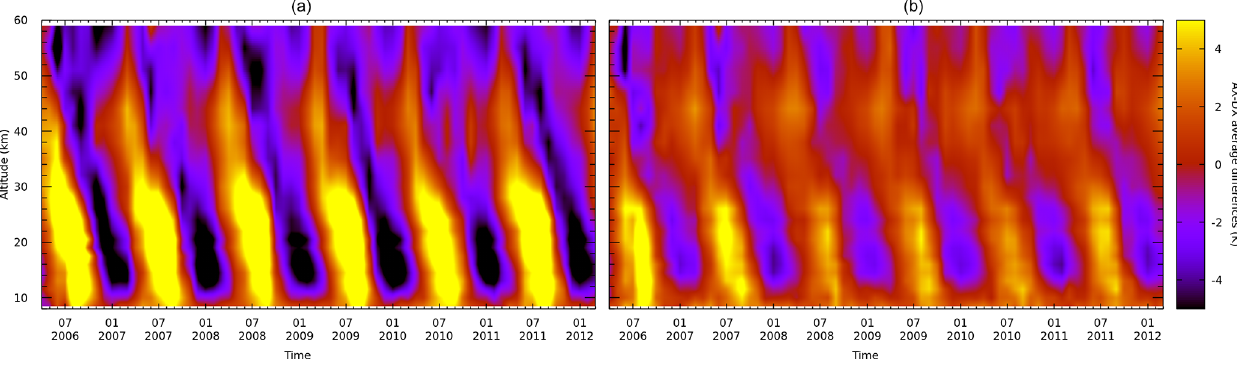
Figure 5. Time series of monthly average temperature ascending–descending difference profiles for V7 (a) and V8 (b) MIPAS/ESA products. The images cover the latitude band from 45 to 60 ◦